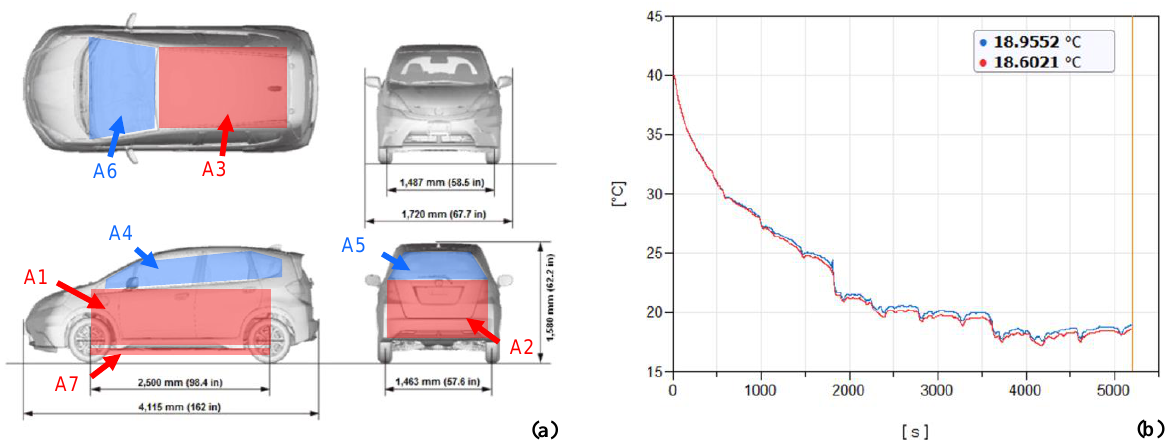
Figure 8. (a) Relevant surfaces for thermal losses; (b) Cabin temperature comparison between standard- and polycarbonate